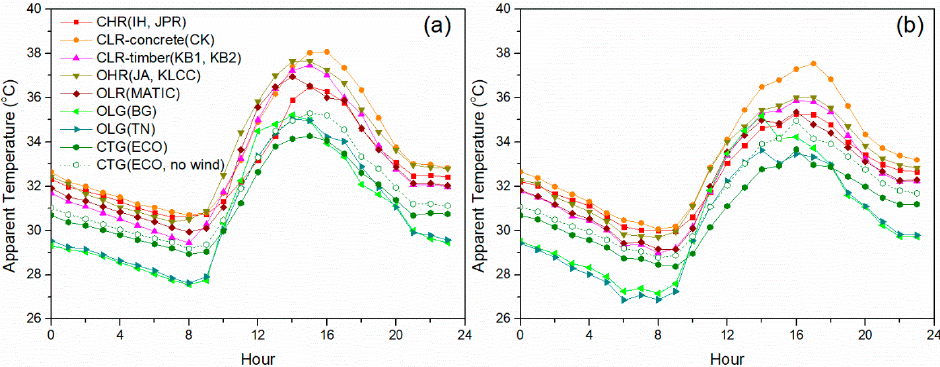
Figure 9. Diurnal variation of calculated apparent temperatures in wet ( a ) and dry ( b ) seasons for different land use areas.